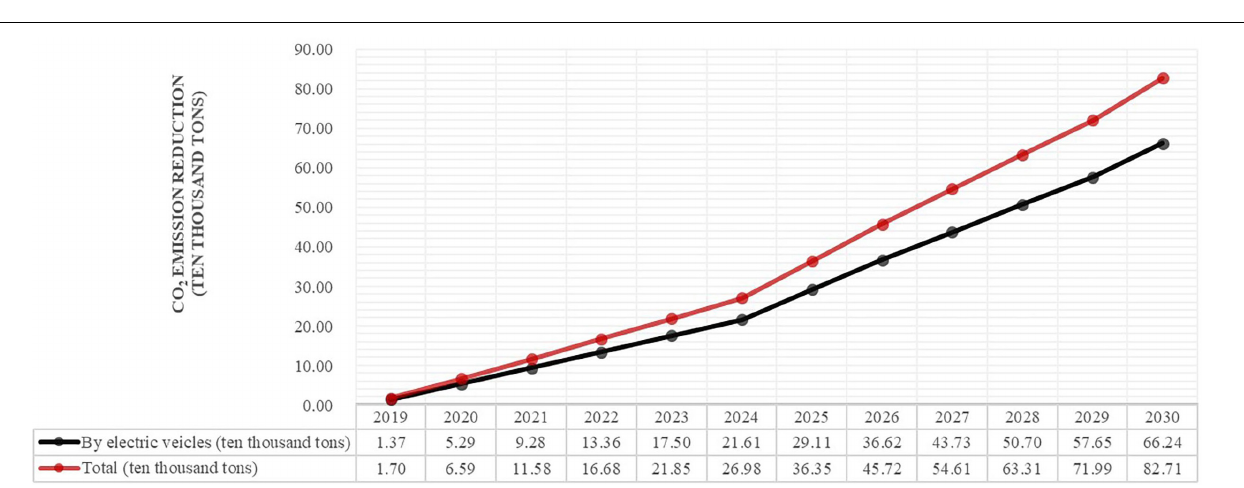
FIGURE 2 | Energy demand in Hainan Island.